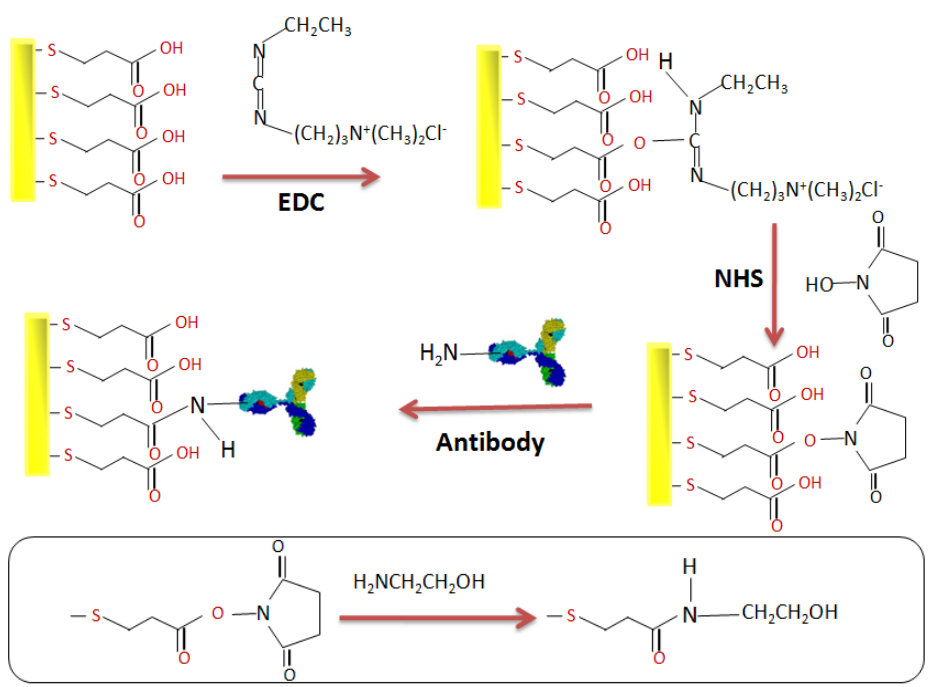
Figure 1. Different stages in the development of the